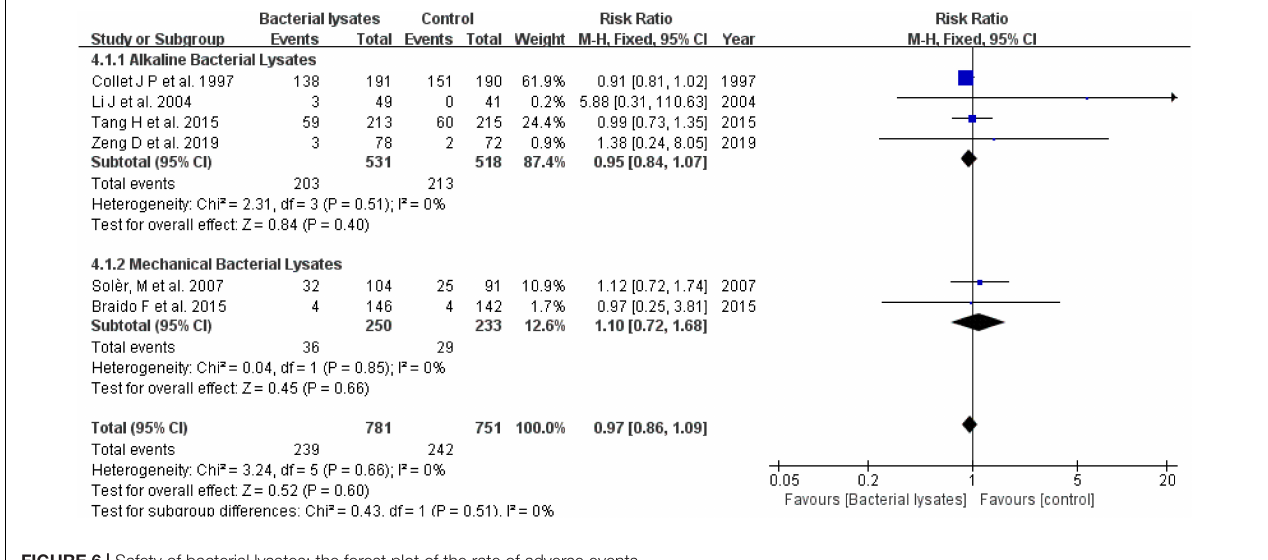
FIGURE 6 | Safety of bacterial lysates: the forest plot of the rate of adverse events. TABLE 3 | The detailed adverse